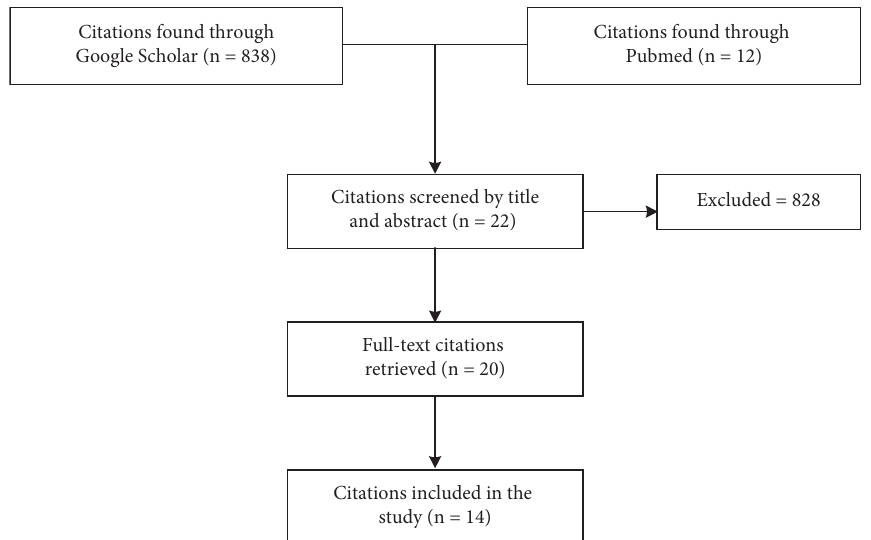
Figure 1: Study eligibility flowchart. Table 1: In vitro studies on the effects of plants against Ancylostoma caninum